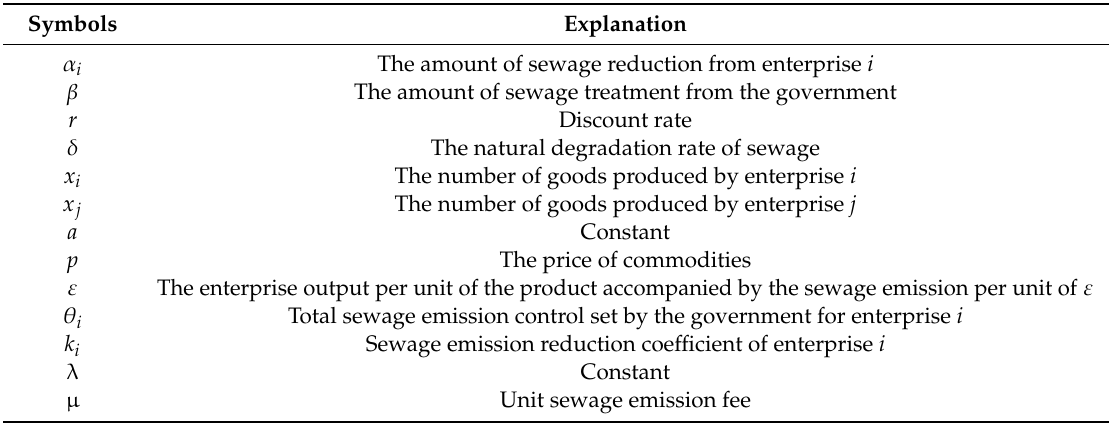
Table A1. List of